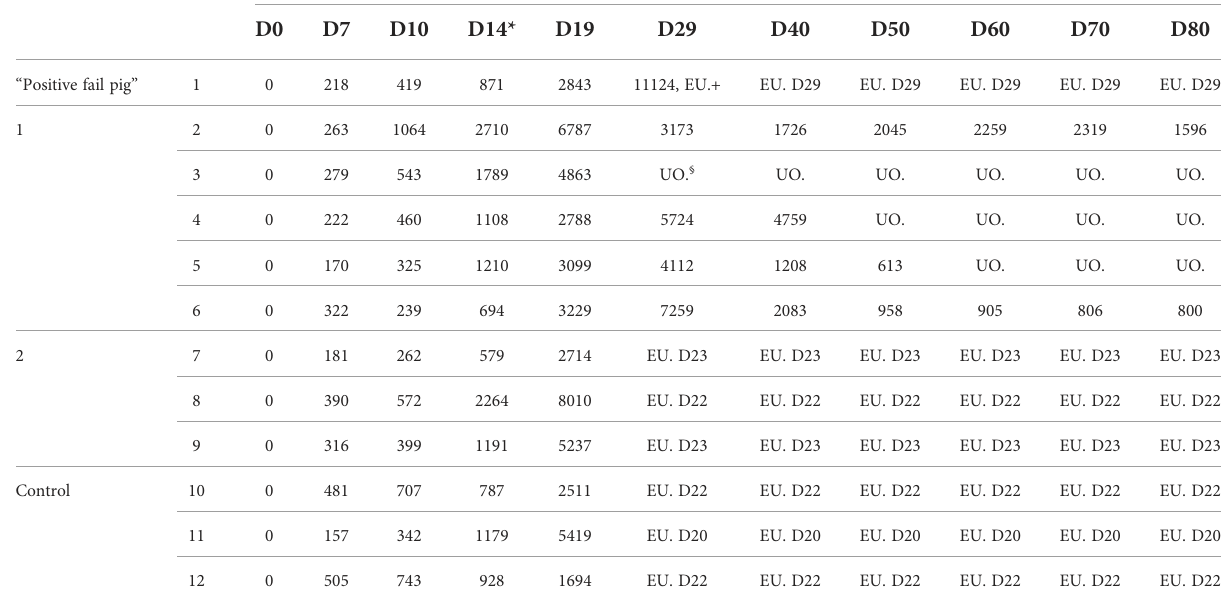
TABLE 3 Tumor volumes (mm 3 ) of the 12 minipigs. Group